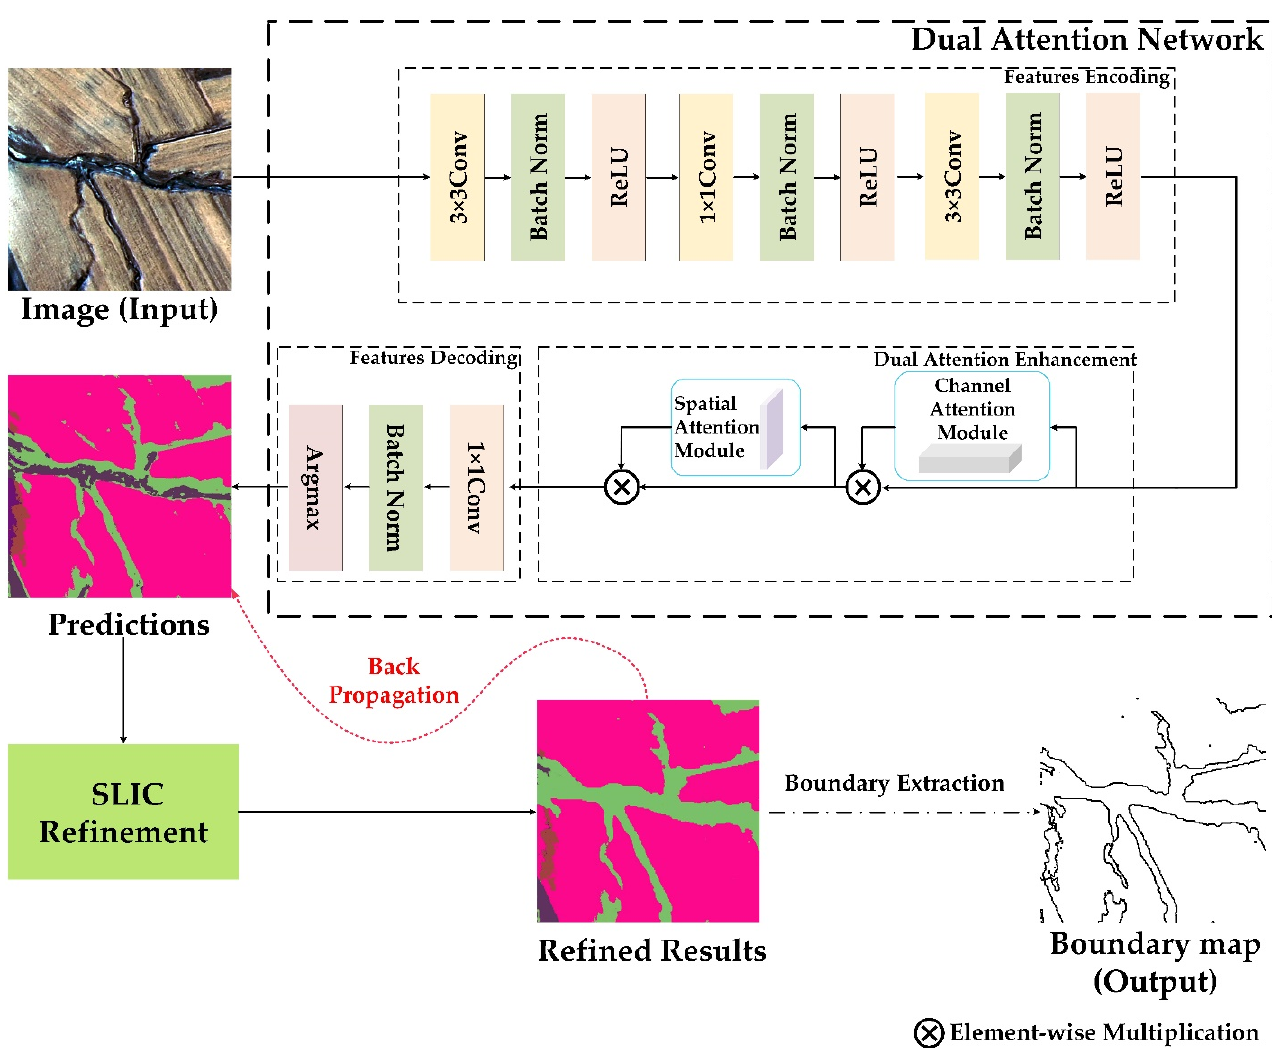
Figure 3. Flowchart of the object boundary generator. Boundary extraction is only performed after iteration has stopped.